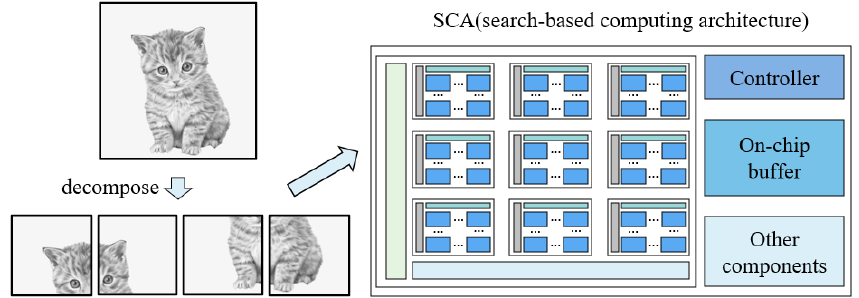
Figure 11. Feature map